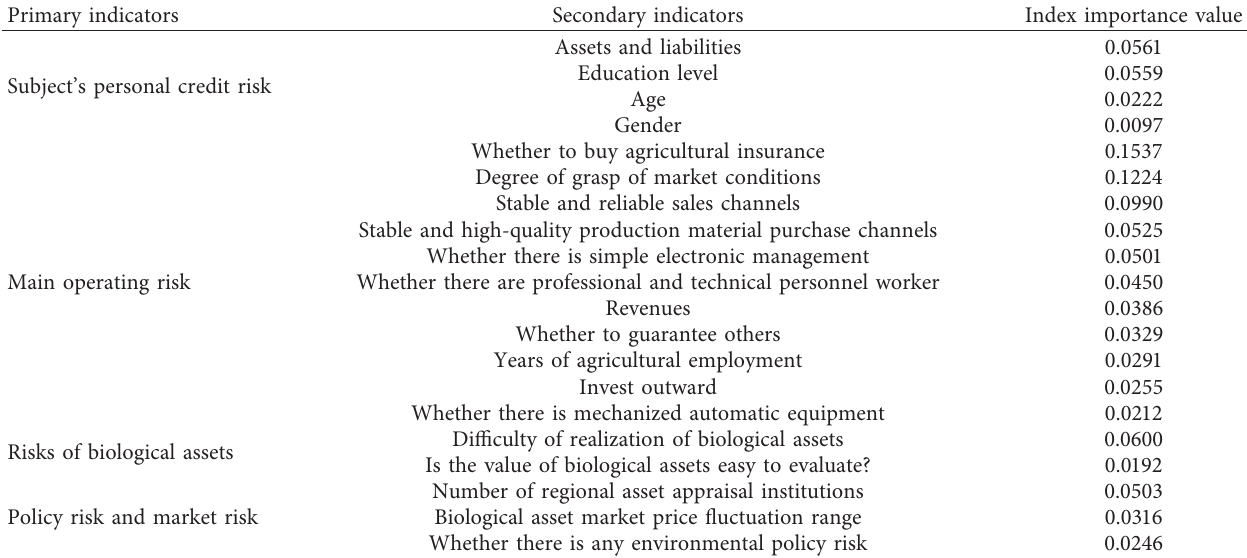
Table 10: The risk assessment index system of biological asset mortgage loans for new agricultural business entities. Primary indicators